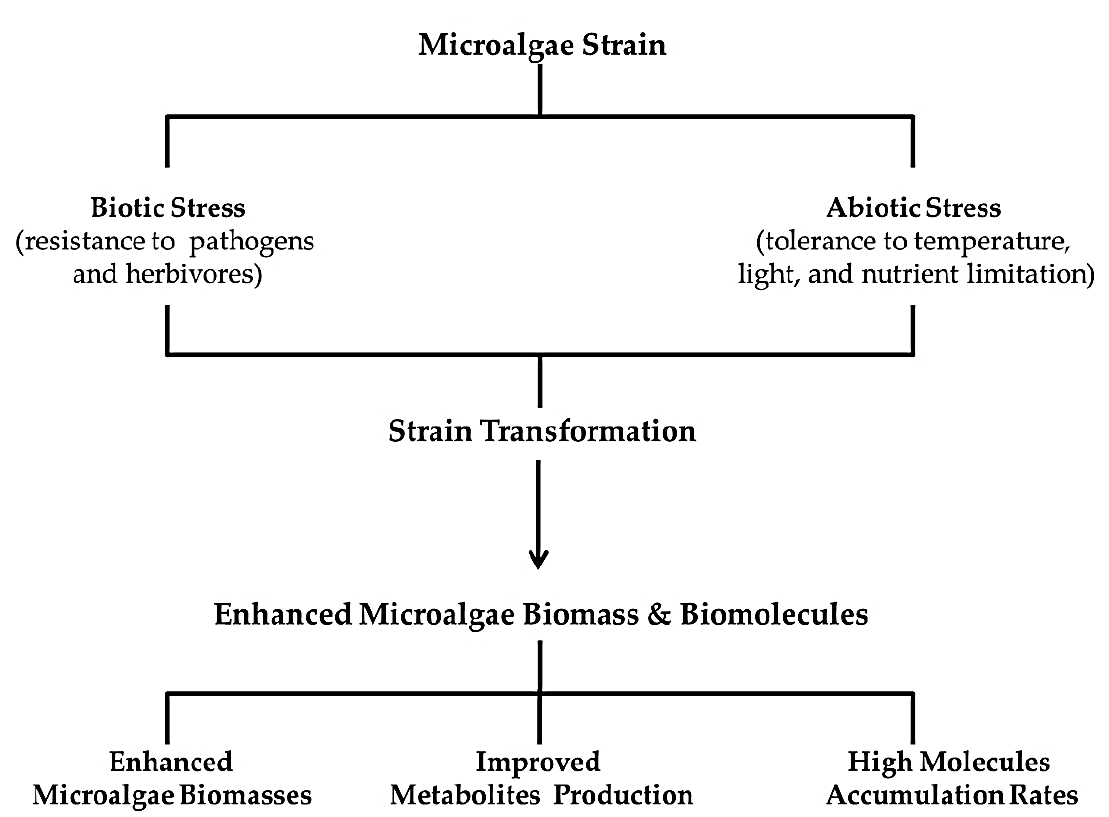
Figure 1. Schematic diagram illustrating the desired implementation of genetic modification traits toward higher production of microalgae biomass.